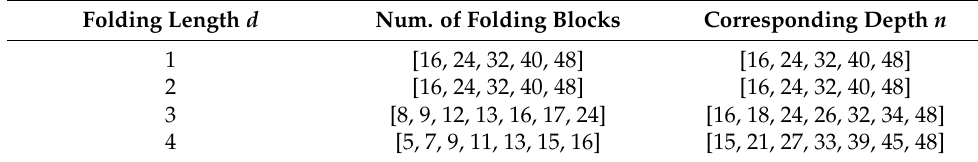
Table 1. Hyperparameter values for CIFAR-10 dataset. The depth n is equal to the number of folding blocks times d − 1. The patch size p and kernel size k are fixed as p = 2 and k = 5. The hidden dimension h was chosen from the set [64, 256].